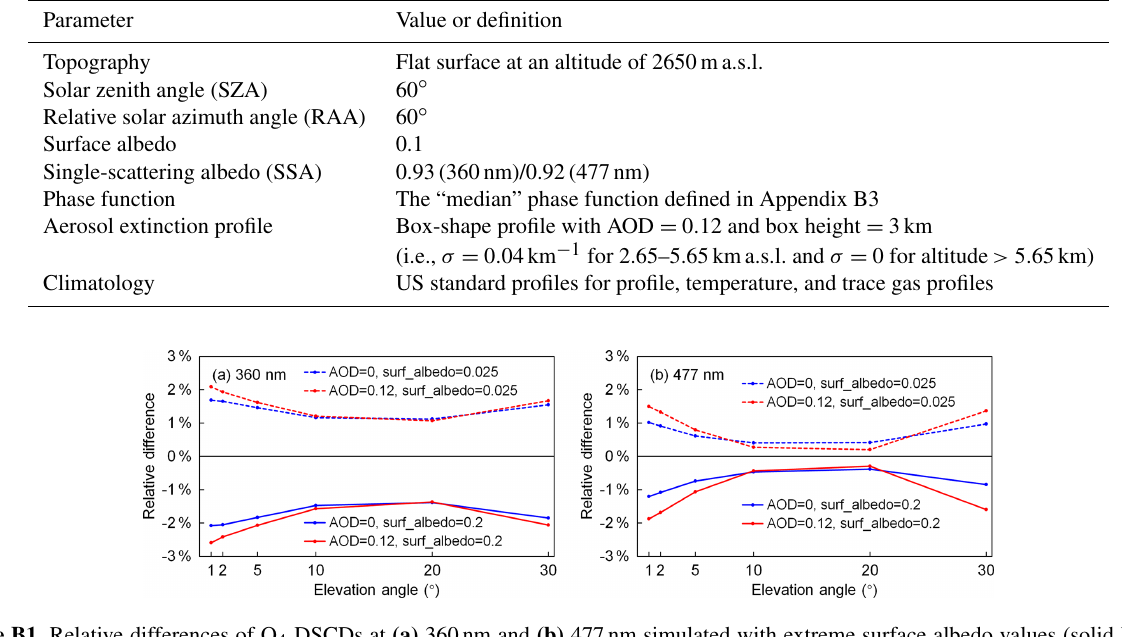
Figure B1. Relative differences of O 4 DSCDs at (a) 360nm and (b) 477nm simulated with extreme surface albedo values (solid lines for 0.2 and dashed lines for 0.025) compared to O 4 DSCDs simulated with the median value (0.1). Blue lines refer to the results under aerosol- free conditions, while red lines refer to the results with a box-shape profile with AOD = 0 . 12 and box height = 3km. The other simulation parameters followed the settings listed in Table B1.